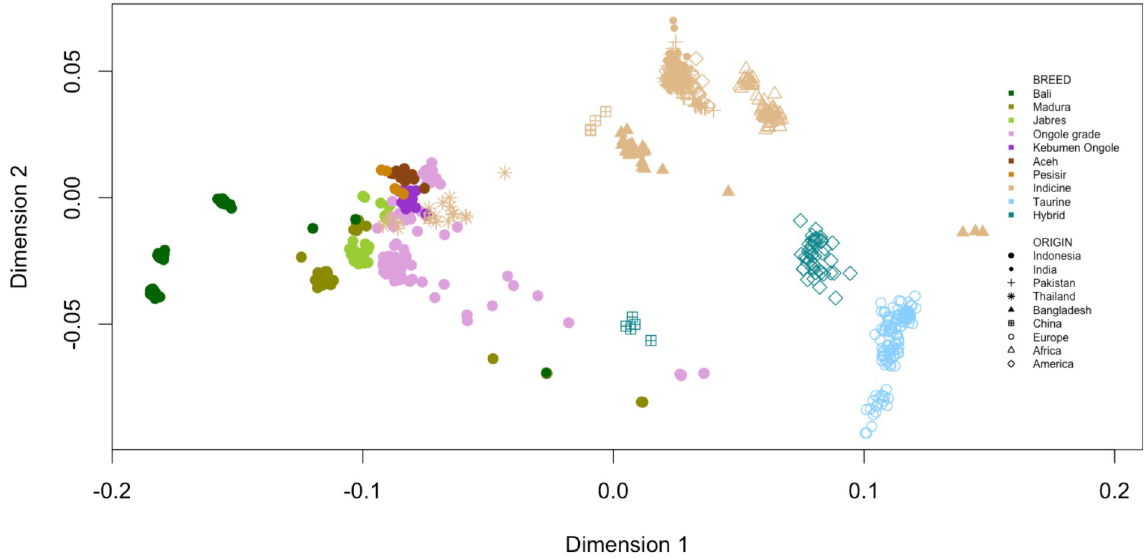
Fig 1. The multi-dimensional scaling plot of Indonesian cattle breeds in the worldwide population context. Points were characterized based on color and shape to define the cattle breed and its origin, respectively.